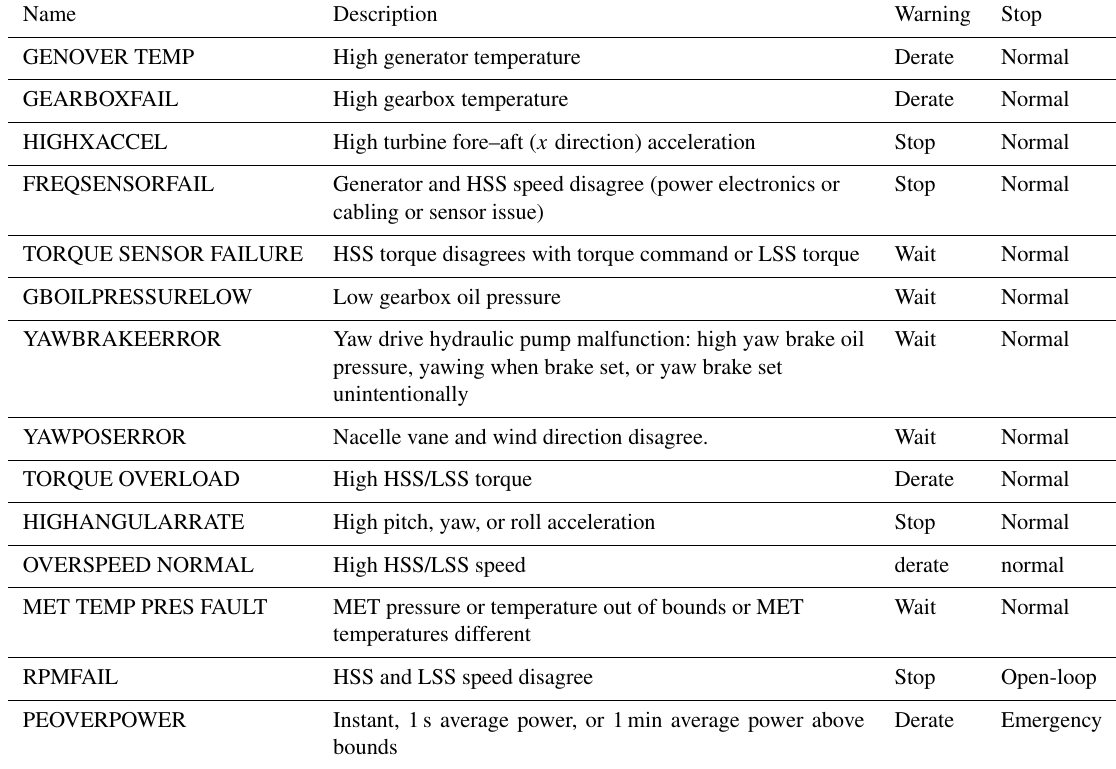
Table 2. Wind turbine faults considered, from the NREL three-bladed Controls Advanced Research Turbine (CART3) controller. Warning: the associated warning type we created for the fault. Stop: the type of shutdown that occurs upon fault. HSS: high-speed shaft. LSS: low-speed shaft. MET: meteorological.